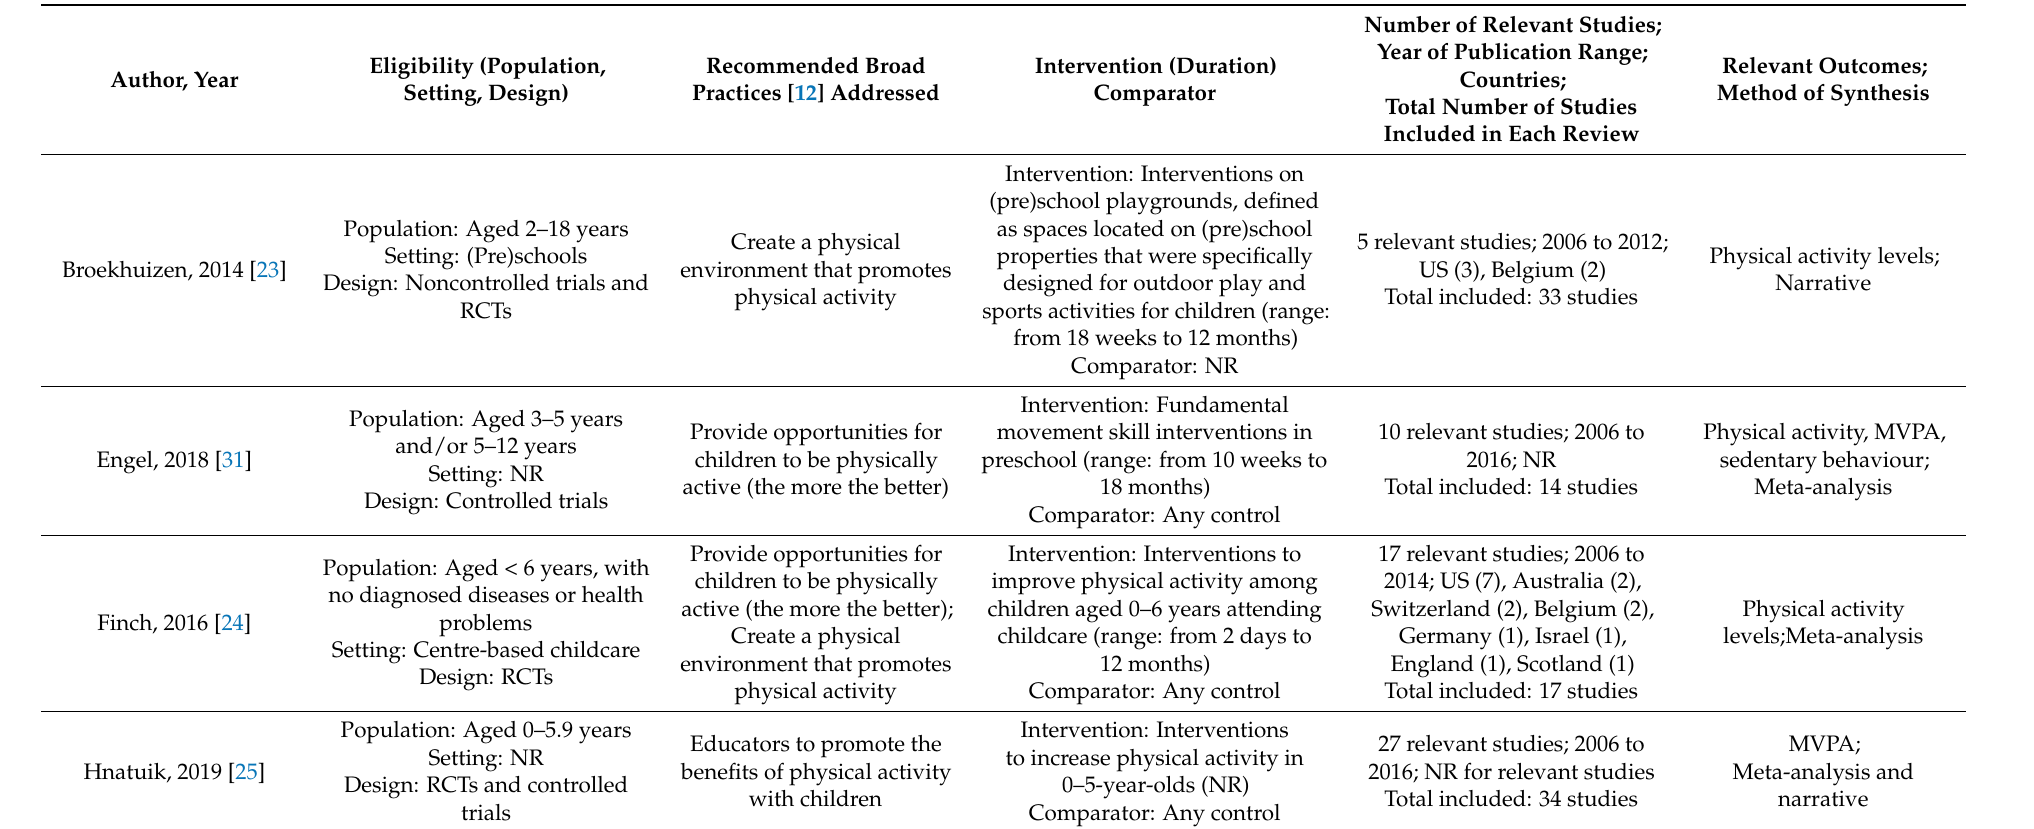
Table 1. Characteristics of the included reviews (n =